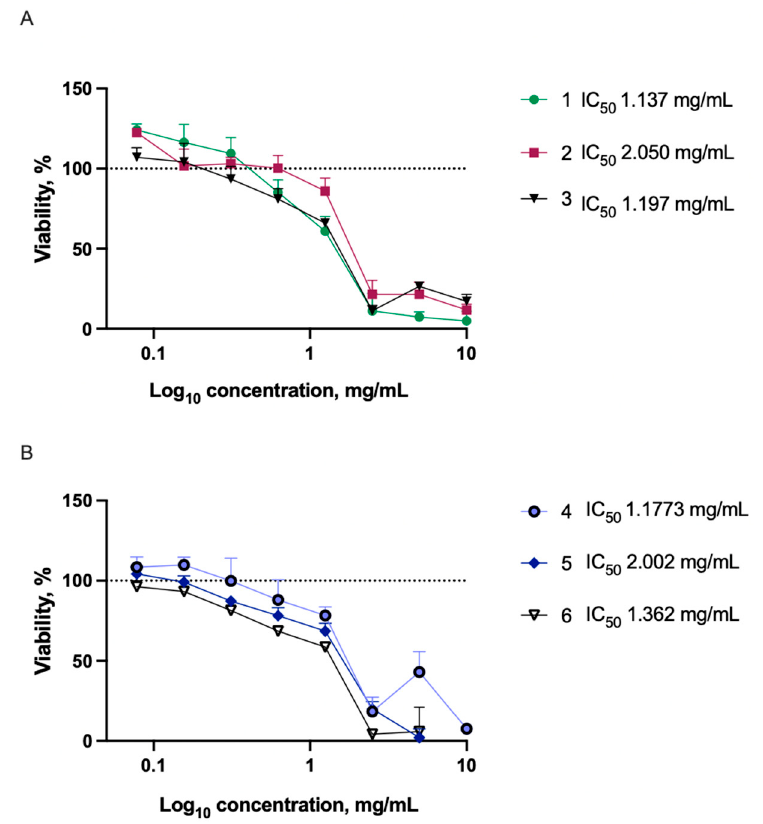
Figure 5. Cytotoxicity of extracts in Balb/c 3T3 cell line. Results expressed as a relative change compared to untreated control. ( A )—50% EtOH extracts: 1—Maria Bruvele; 2—Tatiana; 3—Bot. Lub.; ( B )—water extracts: 4—Tatiana; 5—Bot. Lub.; 6—Maria Bruvele. Data represented as mean ± SD ( n = 3). Dotted line represents the control level (100%).